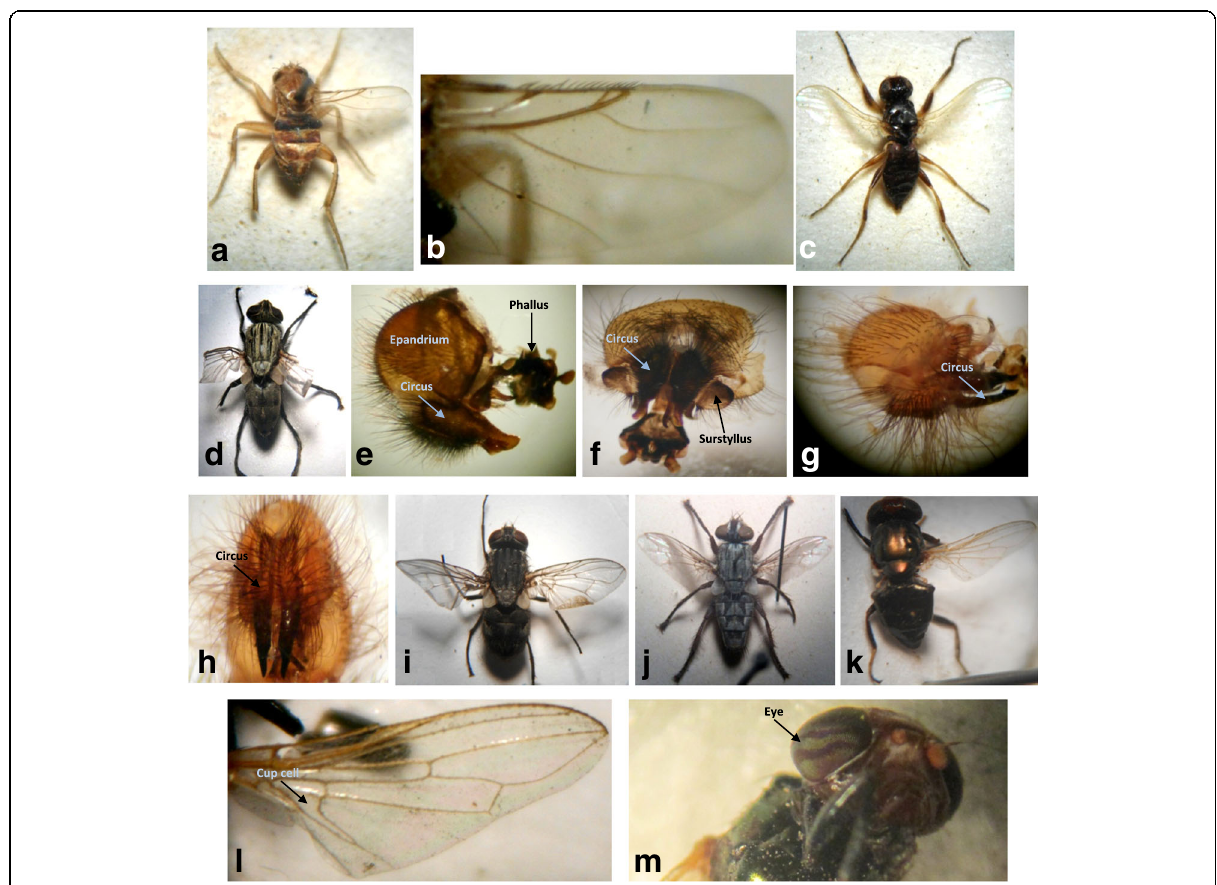
Fig. 3 a, b Megaselia scalaris (Loew, 1866), a adult, b fore wing; c Piophila casei (Linnaeus, 1758), adult; d Wohlfahrtia nuba (Wiedemann, 1830), adult; e, f, i Sarcophaga argyrostoma (Robineau-Desvoidy, 1830), e male genitalia lateral view, f caudal view, i adult; g, h, j Sarcophaga hertipes Weidemann, 1830, g male genitalia lateral view, h caudal view, j adult; k – m Physiphora alceae (Preyssler, 1791), k adult, l fore wing, m head lateral